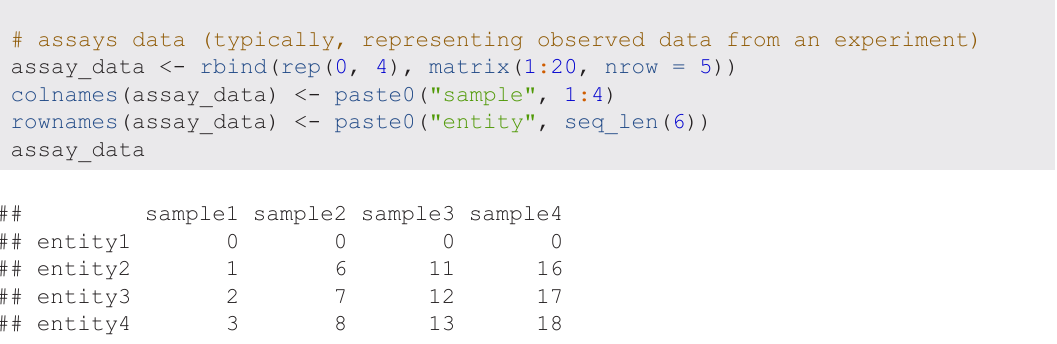
features either as or . All other TreeSummarizedExperiment slots are DNAStringSet DNAStringSetList inherited from SingleCellExperiment .